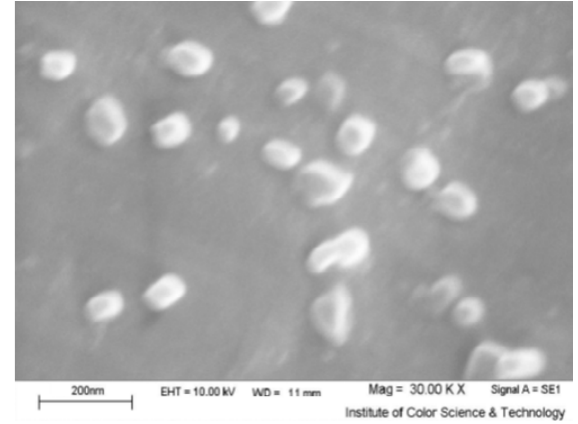
Fig. 1. SEM image of NiO Figure 1. SEM image of NiO nanoparticles